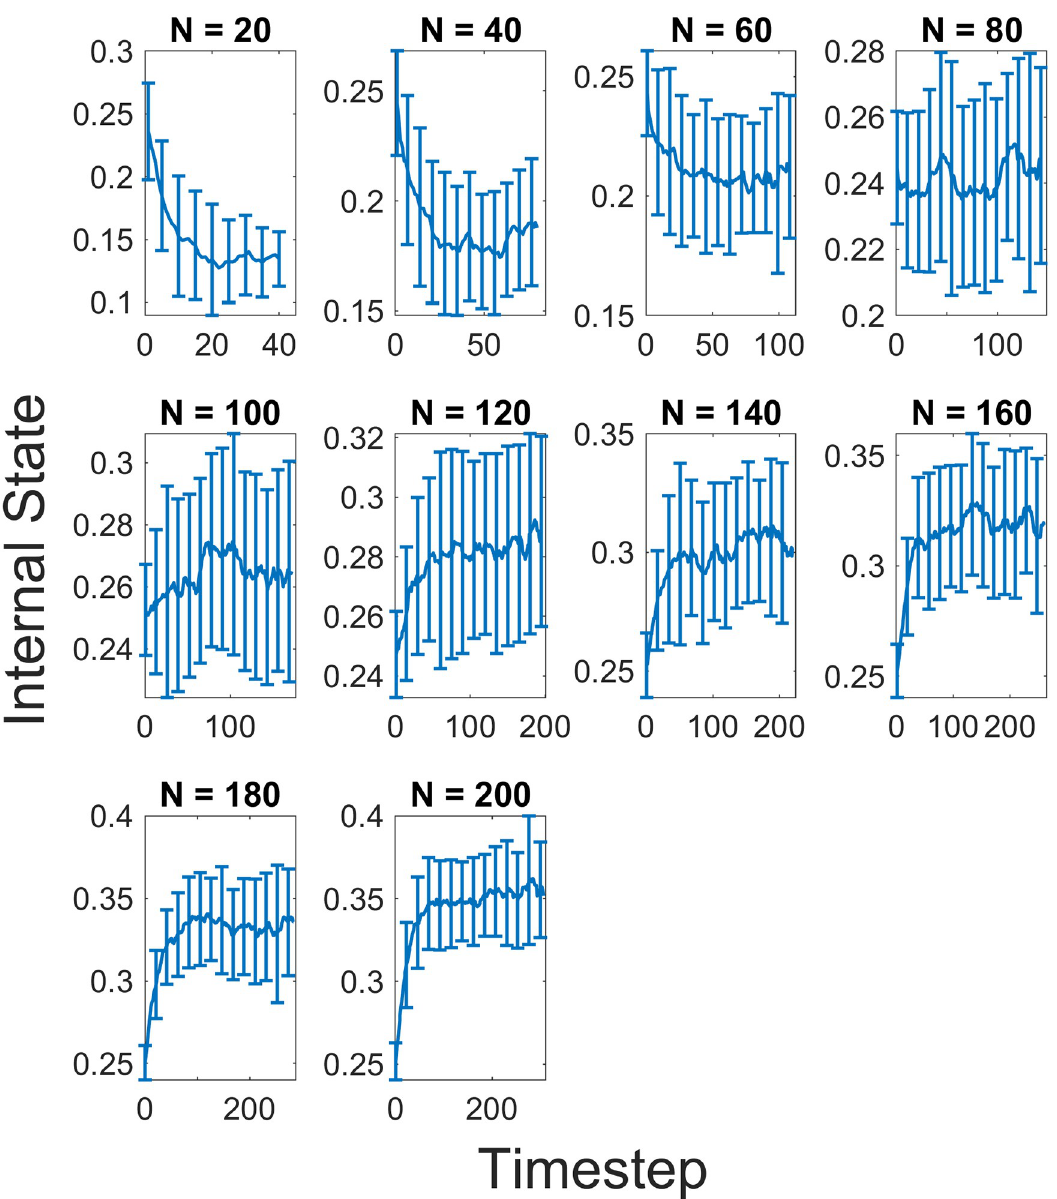
Fig 6. Average internal state of the colony for various colony sizes ( N = 20–200 at increments of 20 workers). As the internal states of workers were initialised randomly between 0 and 0.5, the average initial value for all colony sizes is approximately 0.25. At smaller colony sizes ( N = 20, 40, and 60), the average internal state of workers decreases as a function of time and stabilises at a point which is lower than the initial value. As the colony size becomes larger, there appears to be a transition (at N = 80 and 100) where there is greater fluctuation in the average values over time. At the largest colony sizes ( N = 140 to 200), there is an increase in the average internal state of workers over time. Here too there is stabilisation but at a point higher than the initial